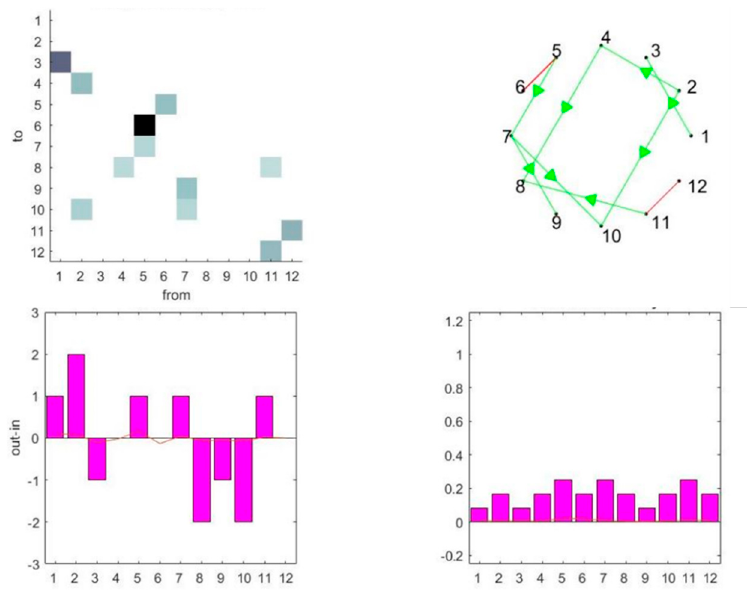
Figure 5. Study B: Demonstration of the GCCA. Matrix and network representations of the corresponding G-causalities are shown in the top panels. Causal flow and unit causal density are shown in the bottom panels.